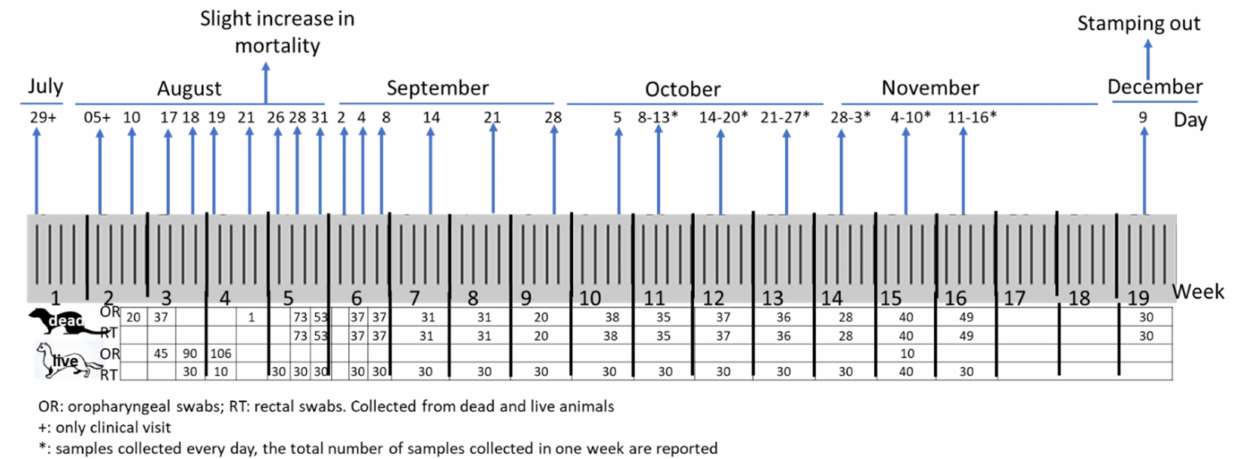
Figure 1. Timeline of and description of samples collected from the